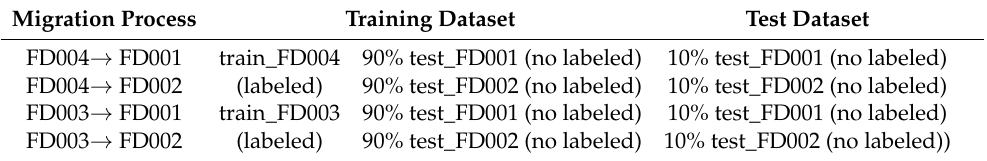
Table 2. Dataset Partitioning.